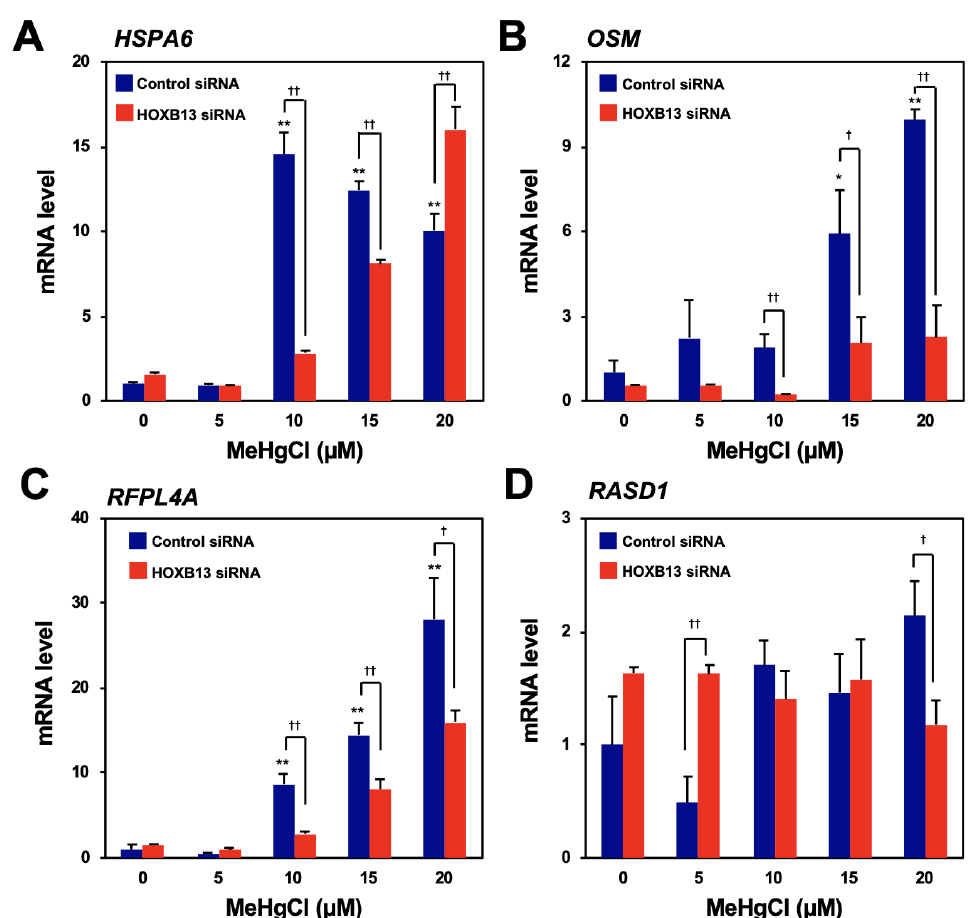
Figure 1. Confirmation of the induction of gene expression by methylmercury via HOXB13. Human embryonic kidney cells (HEK293) cells were transfected with control siRNA or HOXB13 siRNA for 48 h and exposed to indicated concentration of methylmercuric chloride (MeHgCl) for 6 h. Quantitative PCR (qPCR) for the top four genes listed in Table 1 (( A ) HSP6A, ( B ) OSM, ( C ) RFPL4A, and ( D ) RASD1) was performed. Representative data indicate relative values, with control as 1, normalized to each glyceraldehyde-3-phosphate dehydrogenase (GAPDH) mRNA level. The values are presented as mean ± S.D. of three individual experiments. * p < 0.05 vs. control, ** p < 0.01 vs. control, † p < 0.05 vs. control siRNA, †† p < 0.01 vs. control siRNA.